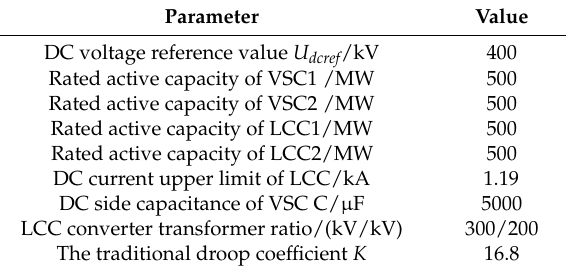
Table 1. Parameters of the simulation system.